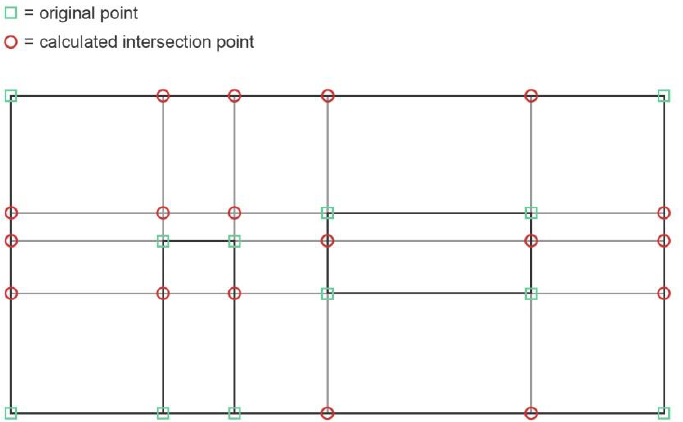
Figure 3. Calculation of intersection points on the orthogonal grid derived from original points.